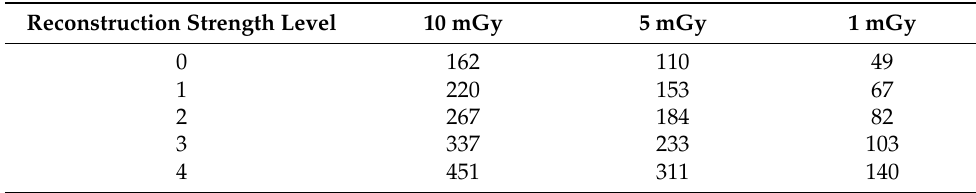
Table 7. Detectability index values when varying the IR level and the CTDI vol for the PCCT scanner for polyenergetic acquisition.